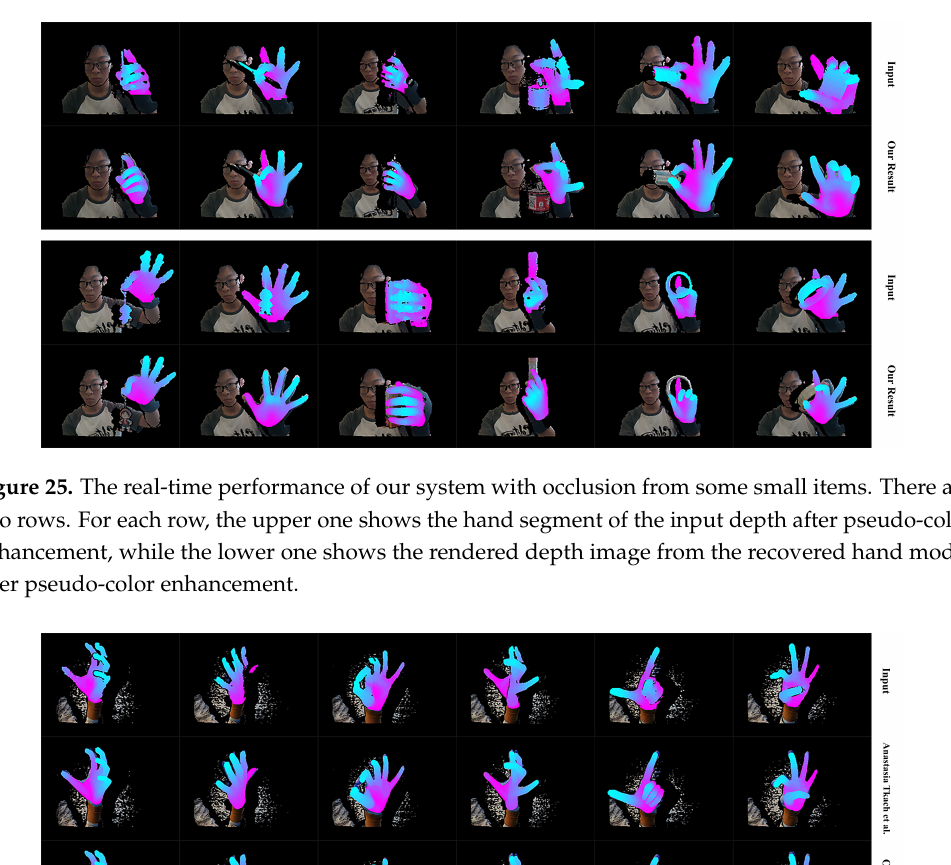
Figure 24. The real-time performance of our system. There are two rows. For each row, the upper one shows the hand segment of the input depth after pseudo-color enhancement, while the lower one shows the rendered depth image from the recovered hand model after pseudo-color enhancement.